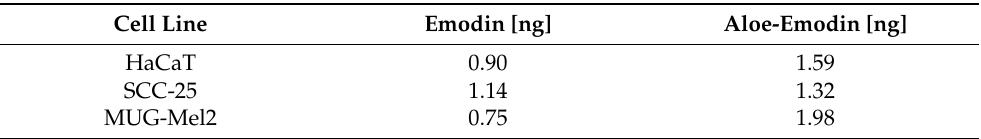
Figure 8. The structure of Emodin (on the left) and Aloe-emodin (on the right). Table 1. Content of emodin and aloe-emodin in three cell lines studied treated with 30 µ m of either compound for 6 h. Values represent the mean of two biological